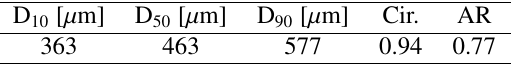
Table 1. Particle size distribution characteristics post